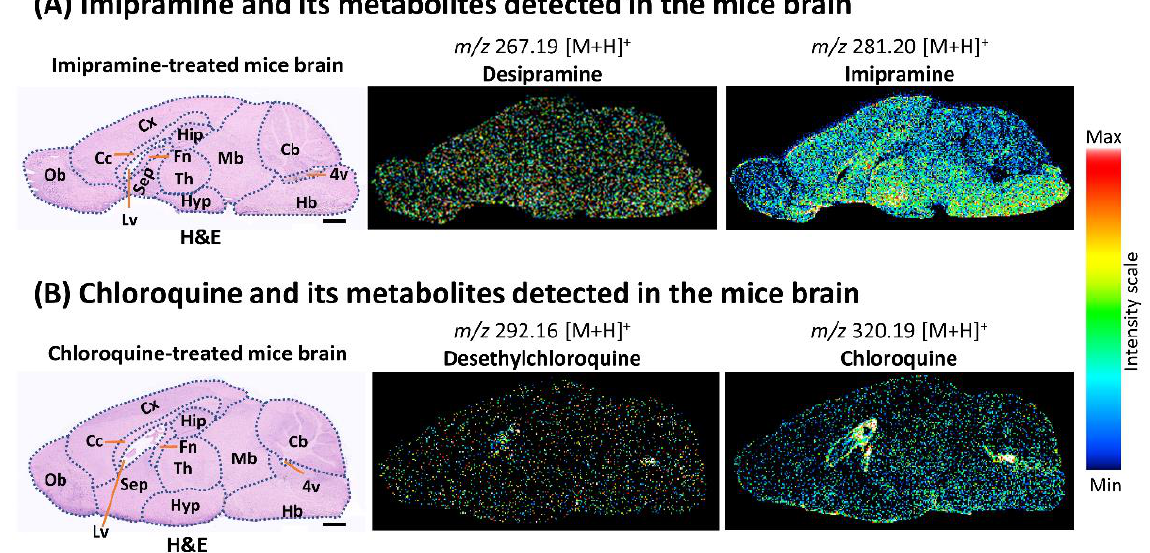
Figure 4. Localization of imipramine, chloroquine, and their metabolites in the brain of treated mice applying iMScope QT. ( A ) Distribution of imipramine and its metabolites in the mice brain. ( B ) Distribution of chloroquine and its metabolites in the mice brain. Cb: cerebellum; Hb: hindbrain;